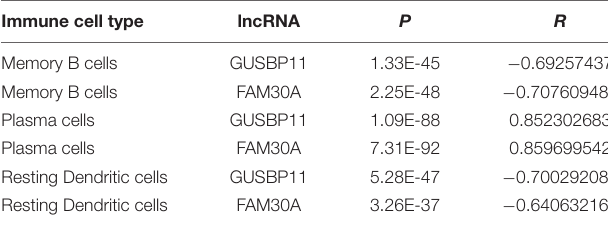
TABLE 2 | Correlation between lncRNAs and immune cell